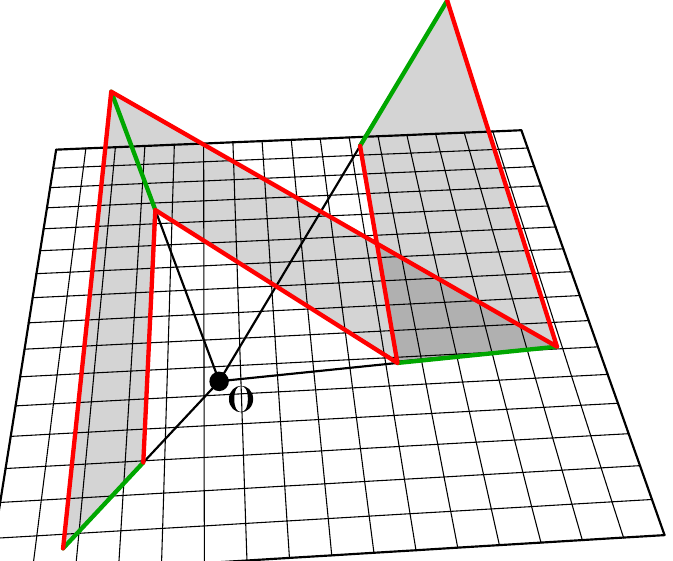
Figure 6. Parallel homothetic polylines (red), scale origin, radial edges (green) and resulting three planar